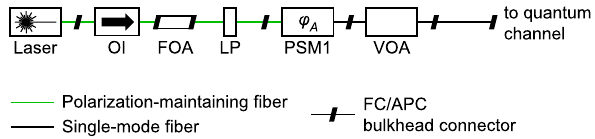
Figure 2. Alice’s optical scheme in detail. Component pigtails are connected using angled ferrule connectors (FC/APC). OI optical isolator, FOA fixed optical attenuator (plug-in style), LP linear polarizer, VOA variable optical attenuator.